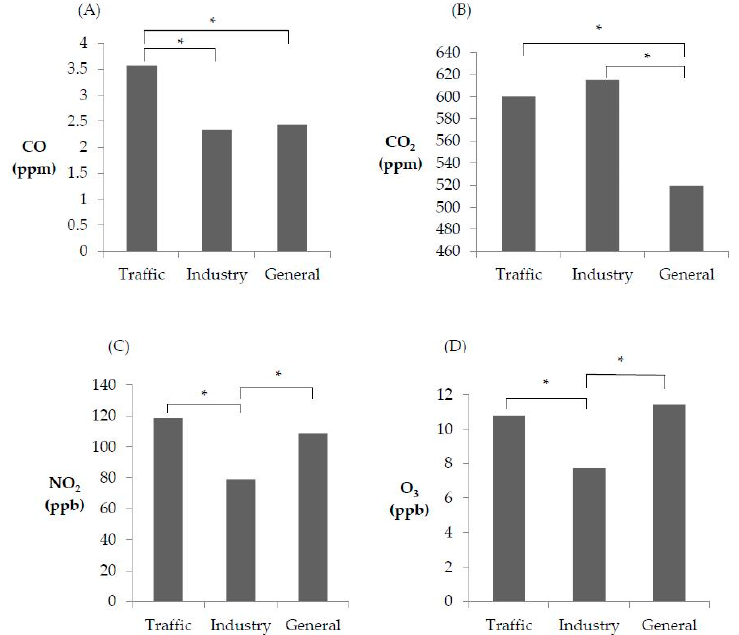
Figure 1. The 24-h average concentration of indoor air pollutants ( A ) CO, ( B ) CO 2 , ( C ) NO 2 , and ( D ) O 3 in the houses of traffic, industry, and general areas. * Scheffe test p < 0.01.